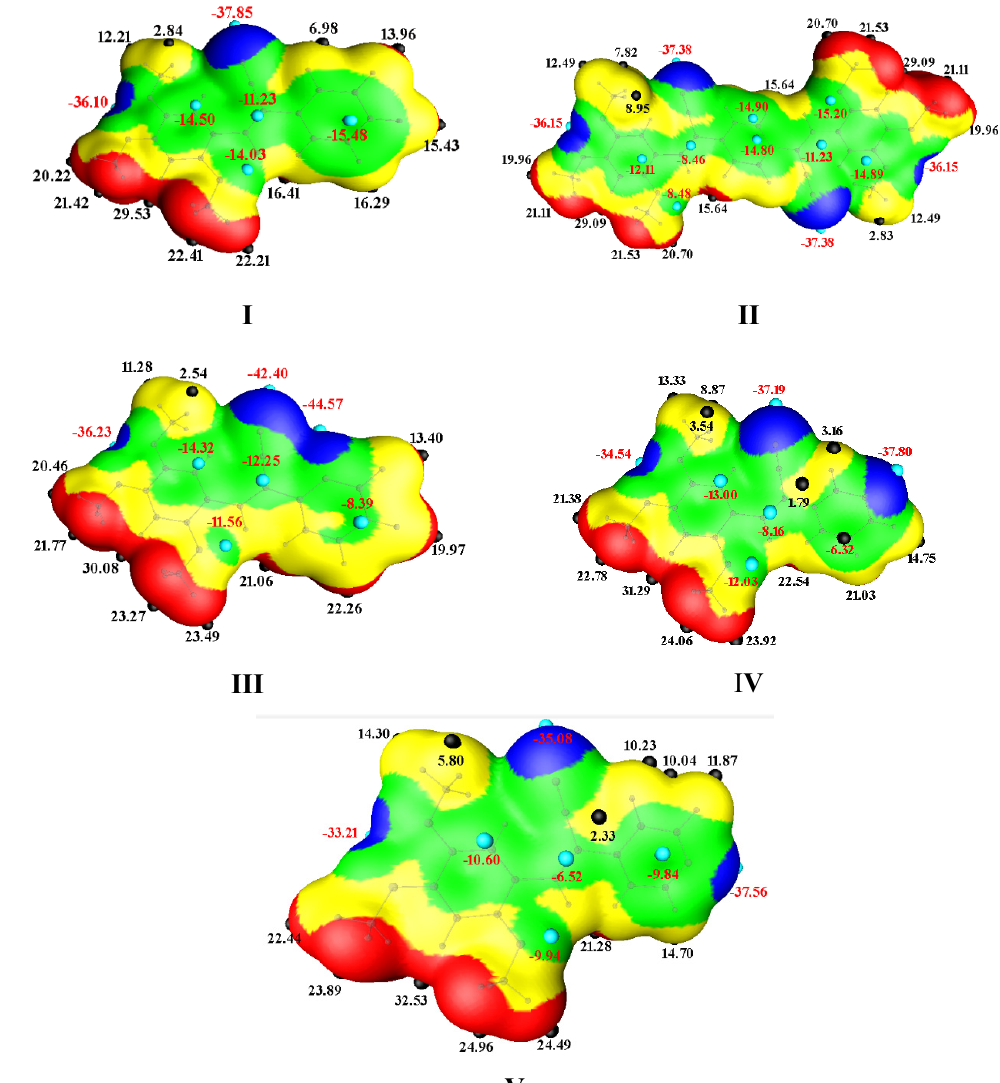
Figure 15. MEPS values of I – V are mapped over the electron density isosurface at 0.001 au. The positive (Vs, max) and negative (Vs, min) potentials are shown as small red and blue spheres, respectively.